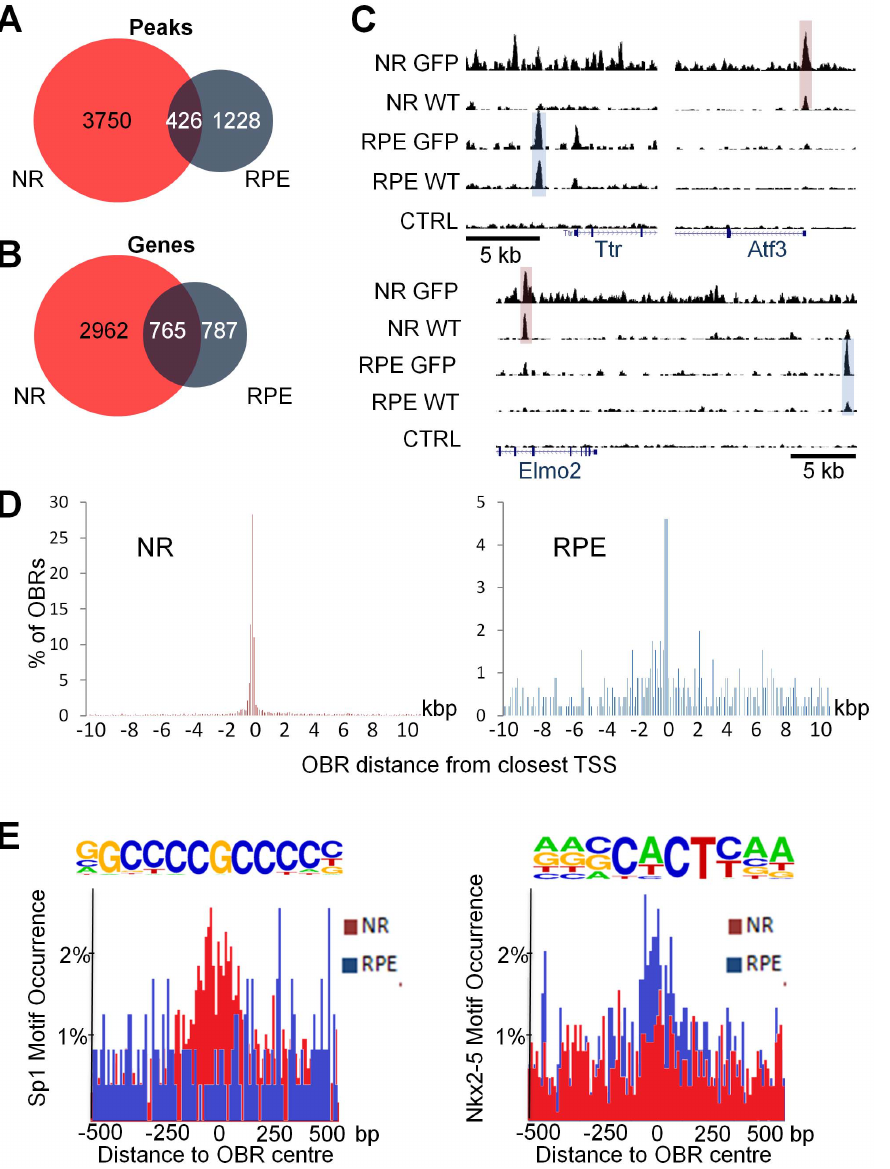
Figure 4. Contrasted Otx2 genome occupancy in neuroretina and RPE. A. Venn diagram showing the overlap of OBR core sets in NR (red) and RPE (blue). B. Venn diagram showing the overlap of the closest genes to core set OBRs. C. Representative examples of OBR localization in RPE- specific (Ttr), NR-specific (Atf3) and common (Elmo2) genes. Shown are browser captures for the 4 ChIP-seq assays and control. The gene is indicated in blue at the bottom. D. Distribution of distance from the closest transcription start site (TSS) in NR and RPE for all OBRs lying within 10 kb from a known TSS. E. Distribution of Sp1 and Nkx2-5 motif occurrence 1 kb around the centre of OBRs in the NR (red) and the RPE (blue).